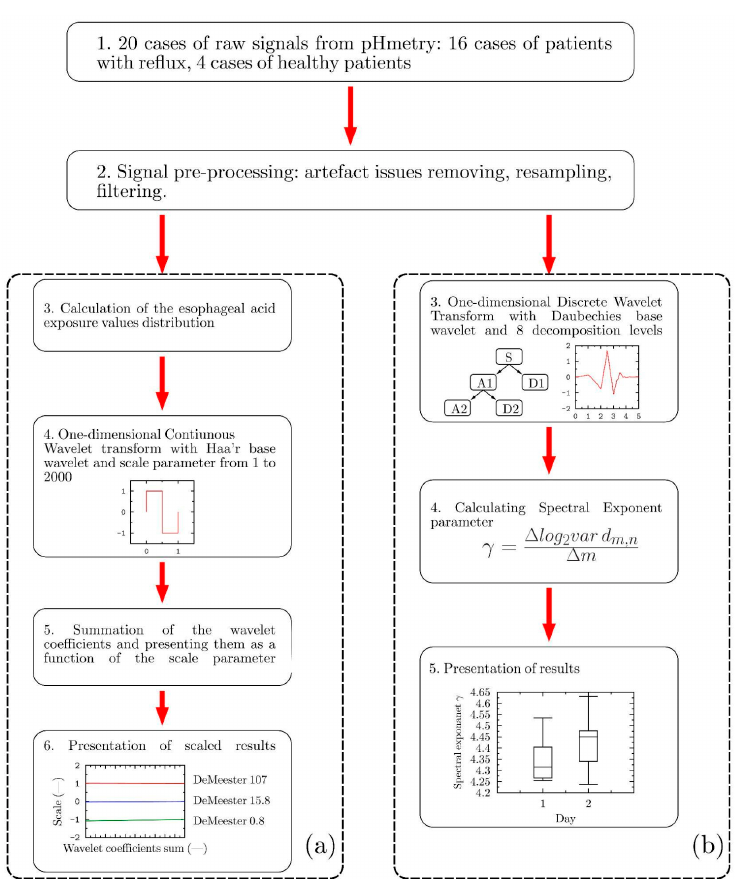
Figure 2. A flow chart for the methodology of analysis for esophageal pH monitoring signal: ( a ) calculation of the sums of wavelet coefficients (CWT), ( b ) based on spectral exponent parameters.